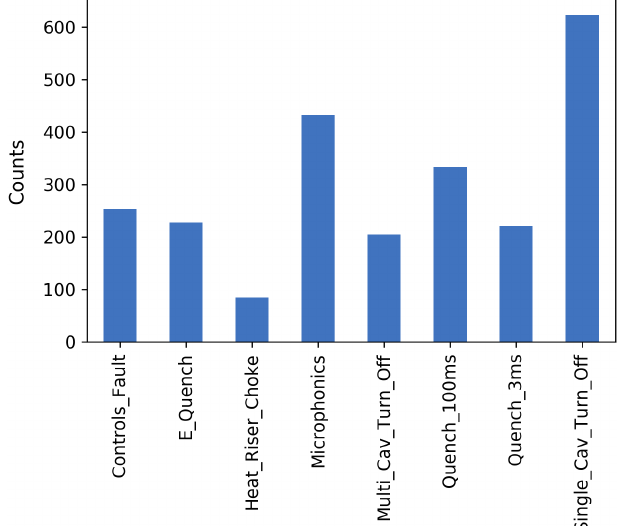
FIG. 4. Histogram showing the distribution of fault events by type. The data represent a total of 2375 unique C100 cavity fault